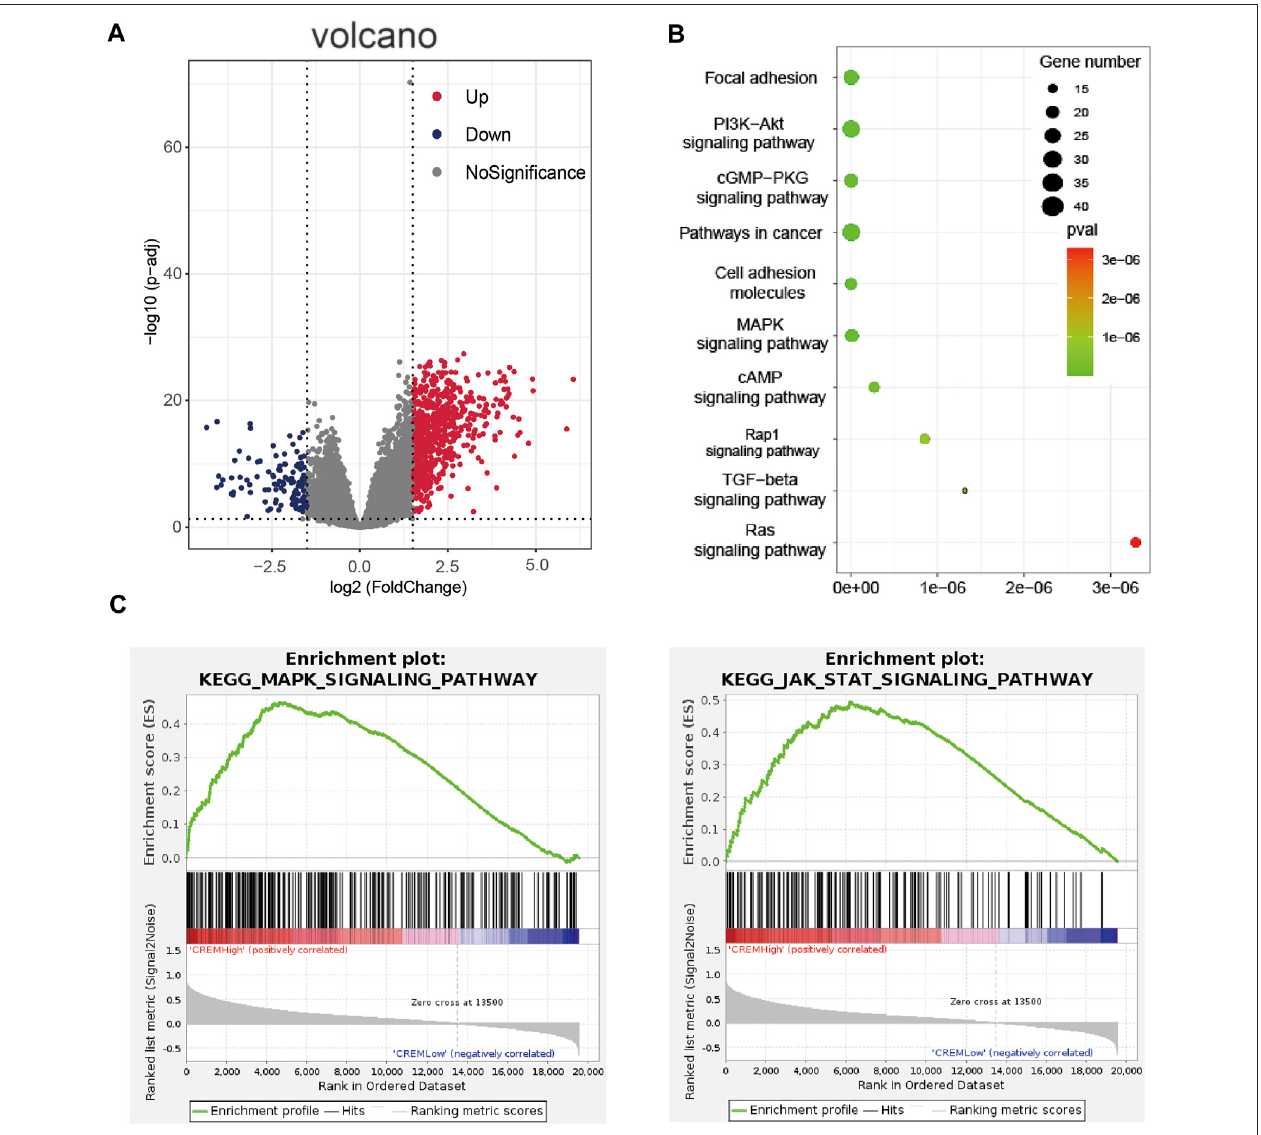
FIGURE 2 | Enrichment analyses of CREM in TCGA GAC (stomach adenocarcinoma). (A) Volcano map of different expression genes between high expression CREM group and low expression CREM group. Red represents upregulation of gene expression, purple represents downregulation of gene expression, and gray representsnodifferenceingeneexpression. (B) EnrichmentanalysisofCREM differentexpression upgenesinKOBAS database withKEGG pathways. Plotsizesshow gene counts enriched in the enrichment of pathway. Color indicates the p-value from low (red) to high level (cyan). (C) Enrichment plot from gene set enrichment analysis including enrichment score. The signi fi cantly enriched signaling pathways were MAPK and JAK-STAT signaling pathway.